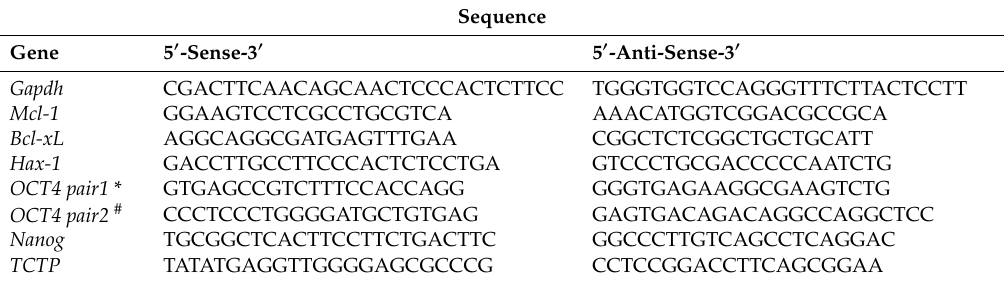
Figure 10. mRNA expression pattern of cell survival-related genes of TCTP-cKO mice compared with littermate controls. ( A – F ) Mcl-1, Hax-1, Oct-4 pair1, Oct-4 pair2, Bcl-xL, and TCTP mRNA expression from control and TCTP-cKO mice at E13.5, E16.5, and P0.5 were detected by qPCR. (Data presented as mean ± SEM, * p < 0.05, ** p < 0.01, *** p < 0.001, Student’s t test, n = 4–11 per group). Table 2. Primer sequences for qPCR gene expression